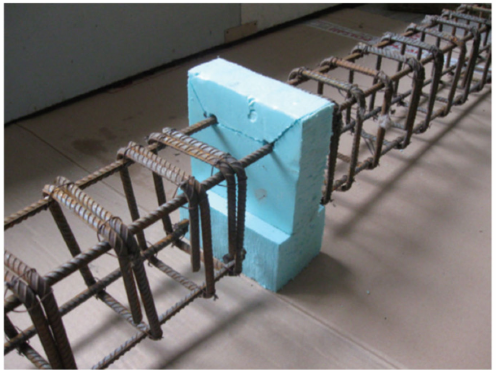
Figure 2. Midspan part of the steel reinforcement skeleton of Series I beams with the foam polystyrene